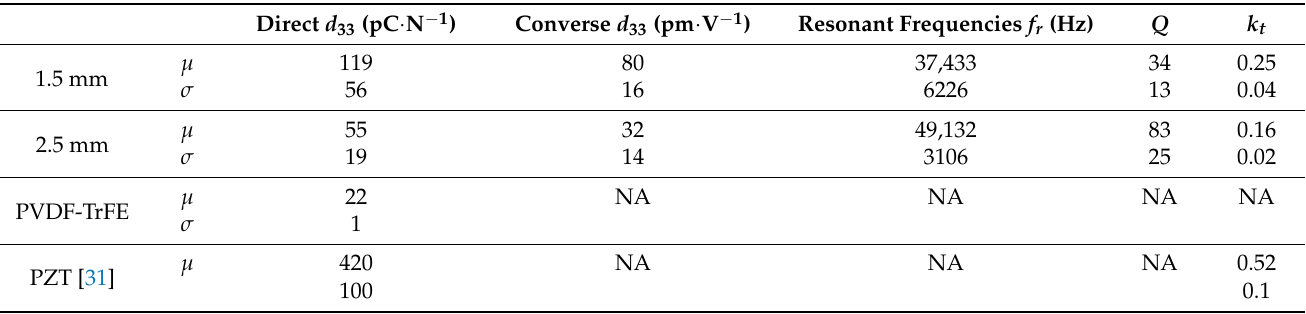
Table 1. Average values ( µ ), and their corresponding standard deviations ( σ ) of direct piezoelectric coefficients calculated from charges harvested under a pressure step of 0 to 1 bar, converse piezoelectric coefficients calculated from static displacement and applied voltage, resonant frequencies ( f r (Hz)), quality factors ( Q ), and thickness coupling factors ( k t ) extracted from impedance spectra. for two thicknesses (1.5 mm and 2.5 mm) of RS/PLA composite samples and for a commercial PVDF-TrFE sample. Thick ceramic (Pb(Mg 1/3 Nb 2/3 ) O 3 -PbTiO 3 -PbZrO 3 ) published data from the literature is also presented as reference [31]. NB: Rochelle salt (unstable) stated relative permittivity ( ε 33 ) =